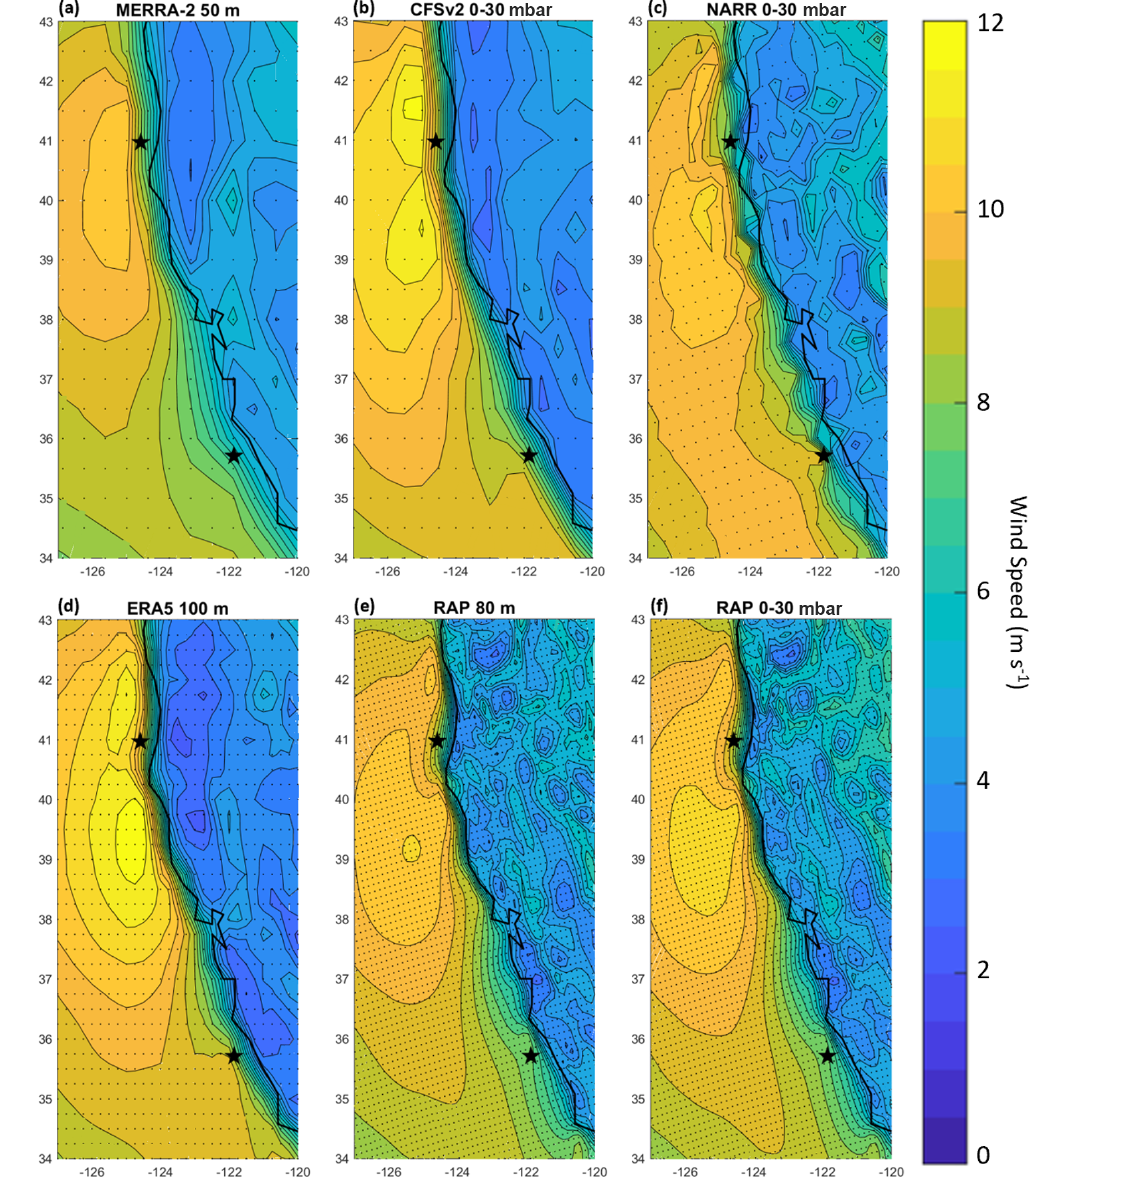
Figure 3. Average wind speed over the period 1 October 2020 through 30 September 2021 from (a) MERRA-2 at 50ma . s . l . , (b) CFSv2 over the lowest 0–30mbar layer above sea level, (c) NARR over the lowest 0–30mbar layer above sea level, (d) ERA5 at 100m, (e) RAP at 80m, and (f) RAP over the lowest 0–30mbar layer above sea level. Buoy deployment locations are indicated with stars. Model grid points are indicated with